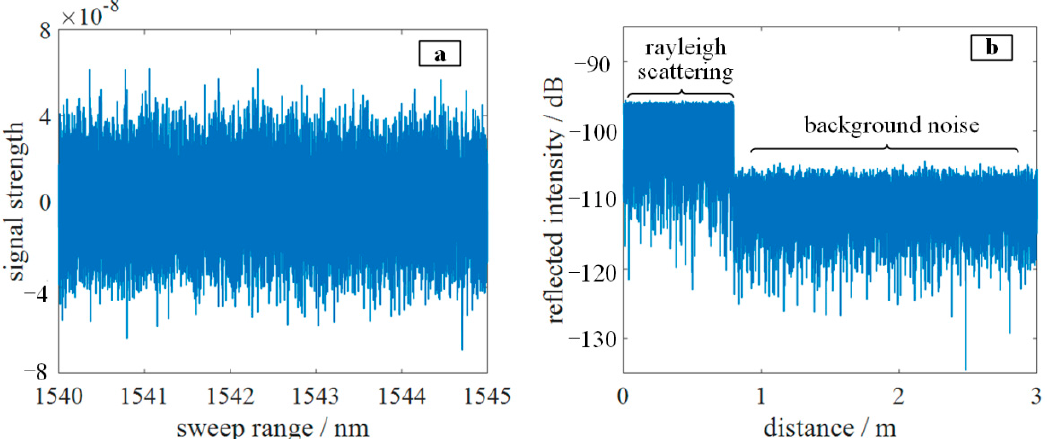
Figure 1. Schematic diagrams of Rayleigh scattering simulation of optical fiber: ( a ) Rayleigh scattering signals in the frequency domain; ( b ) Rayleigh scattering signal in the range domain (Rayleigh spectra).